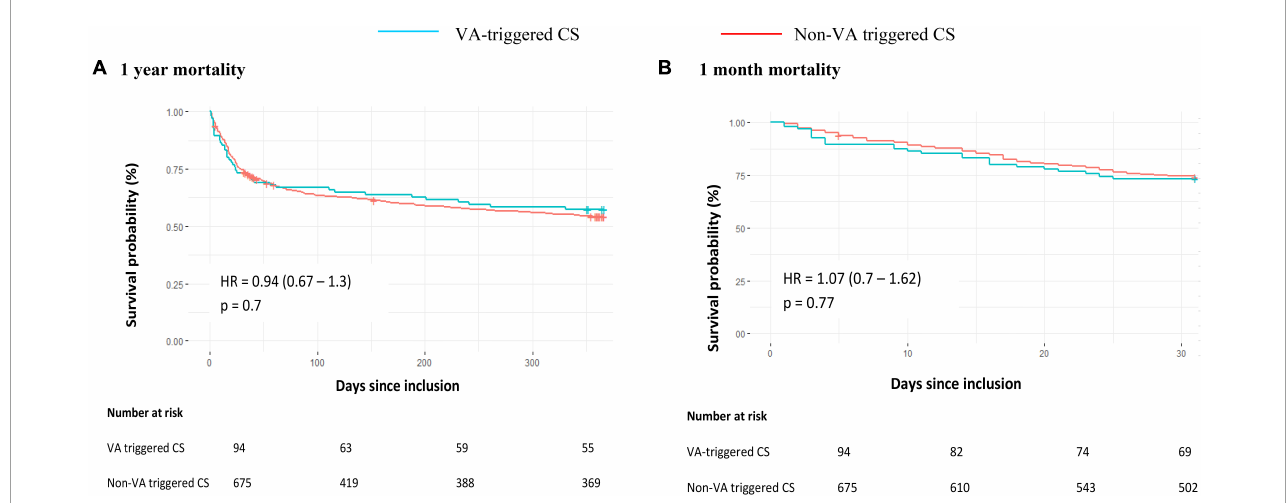
FIGURE1 All-cause mortality in patients with cardiogenic shock according to a ventricular arrhythmia trigger at 1 year (A) and 1 month (B) . The cumulative incidences of 1-year and 1-month mortality were estimated with the use of the Kaplan–Meier method; hazard ratios and 95% confidence intervals were estimated with the use of Cox regression models. CS, cardiogenic shock; HR, hazard ratio; SVT, supra-ventricular tachycardia; VA, ventricular